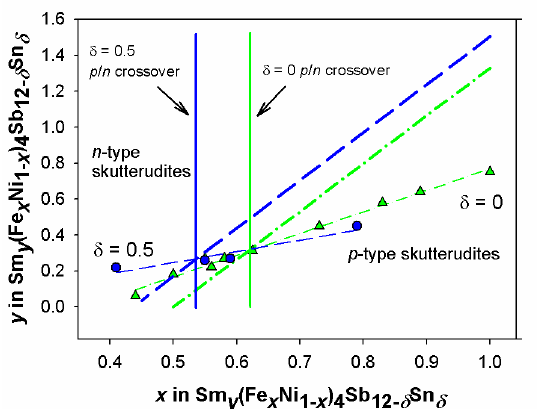
Figure 6. Sm content ( y ) in Sm y (Fe x Ni 1 − x ) 4 Sb 12 − δ filled skutterudites as a function of x. The thick dash-dot green and dashed blue lines represent the theoretical Sm amount necessary to reproduce the electronic count of a compensated semiconductor in the Sm y (Fe x Ni 1 − x ) 4 Sb 12 and Sm y (Fe x Ni 1 − x ) 4 Sb 11.5 Sn 0.5 systems, respectively; the thin ones are the regression lines interpolating experimental points; vertical lines highlight the position of the p / n crossover for both systems. Error bars are hidden by data markers; the data of the Sm y (Fe x Ni 1 − x ) 4 Sb 12 system are taken from ref. [29].